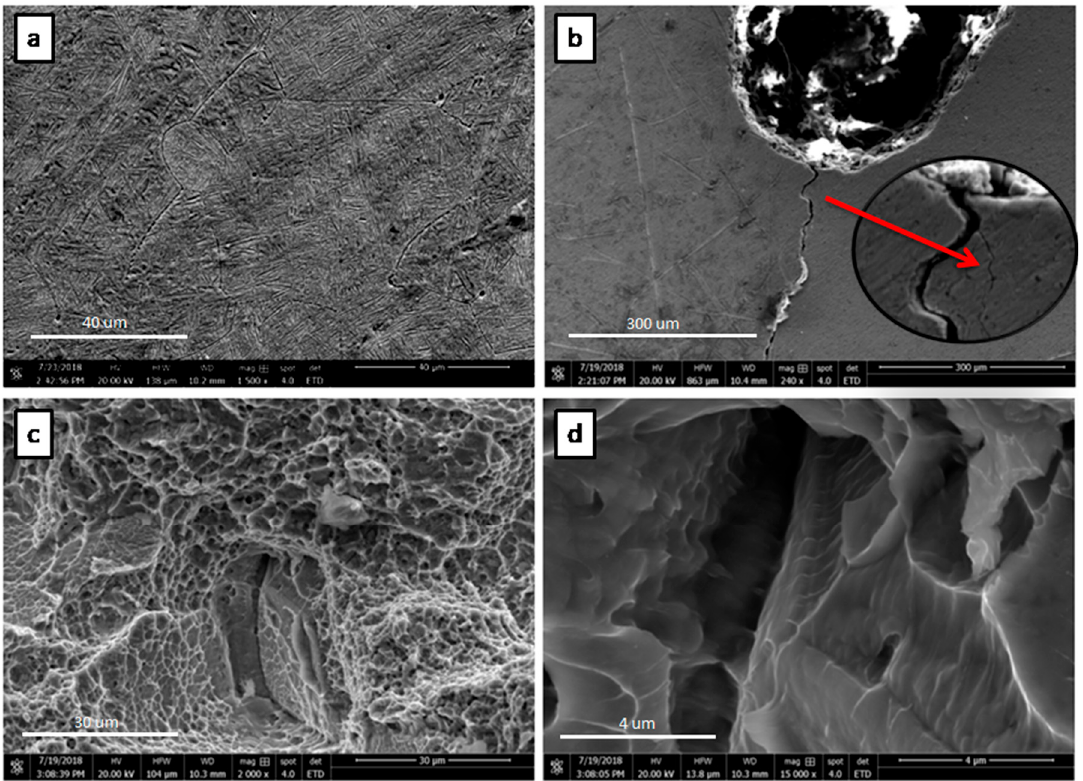
Figure 7. Field emission scanning electron microscopy (FESEM) micrograph of the Ti-27Nb specimen tested under fatigue load. ( a ) The surface microstructure shows Widmanstätten lath structure, ( b ) the deflection and branching of crack ( c , d ) fracture surface.